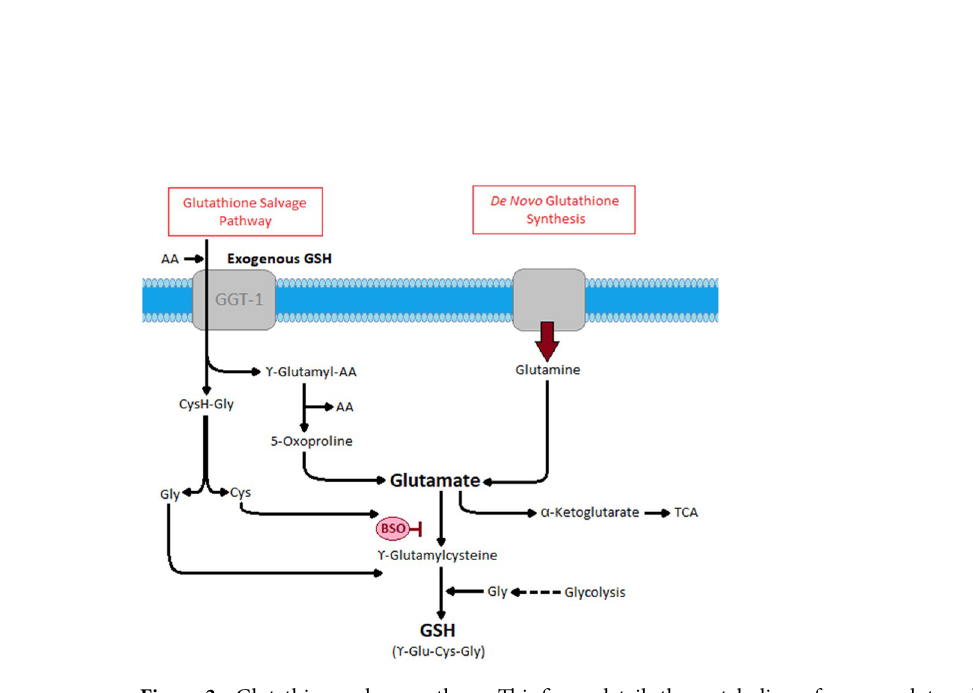
Figure 3. Glutathione salvage pathway. This figure details the metabolism of gamma-glutamyl amino acids to glutathione, a major cellular defense mechanism of oxidative